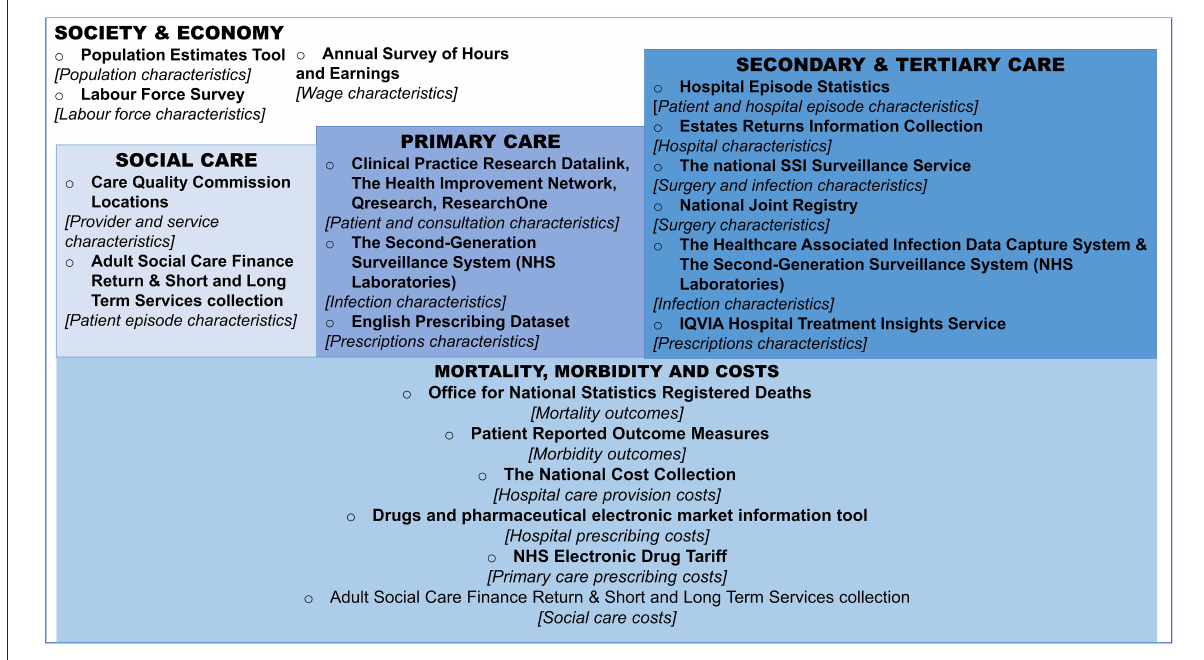
FIGURE1 Overview of datasets for the estimation of antimicrobial resistance impact on surgery patients in England. Boxes represent the setting and/or type of the data, bullet points represent the name of the dataset, followed by a high-level description the use of the dataset in square brackets, for the purposes of Surgical Site Infection and Antimicrobial Resistance research. For more information on data sources (see Supplementary Table A1). NHS, national health service; SSI, surgical site